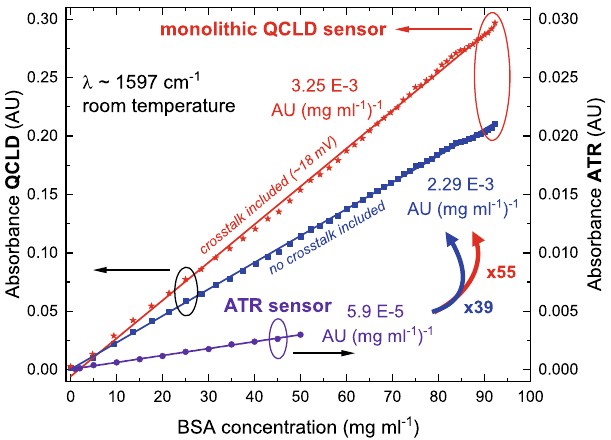
Fig. 4 | Absorbance vs concentration measurements at 1597cm − 1 . Results in absorbance units (AU) of the QCLD sensor for BSA in D 2 O with (red stars) and without (blue squares)18-mVcrosstalkcorrection(left scale)and incomparisonto the single-re fl ection ATR-FTIR system (violet circles, right scale). The right scale is